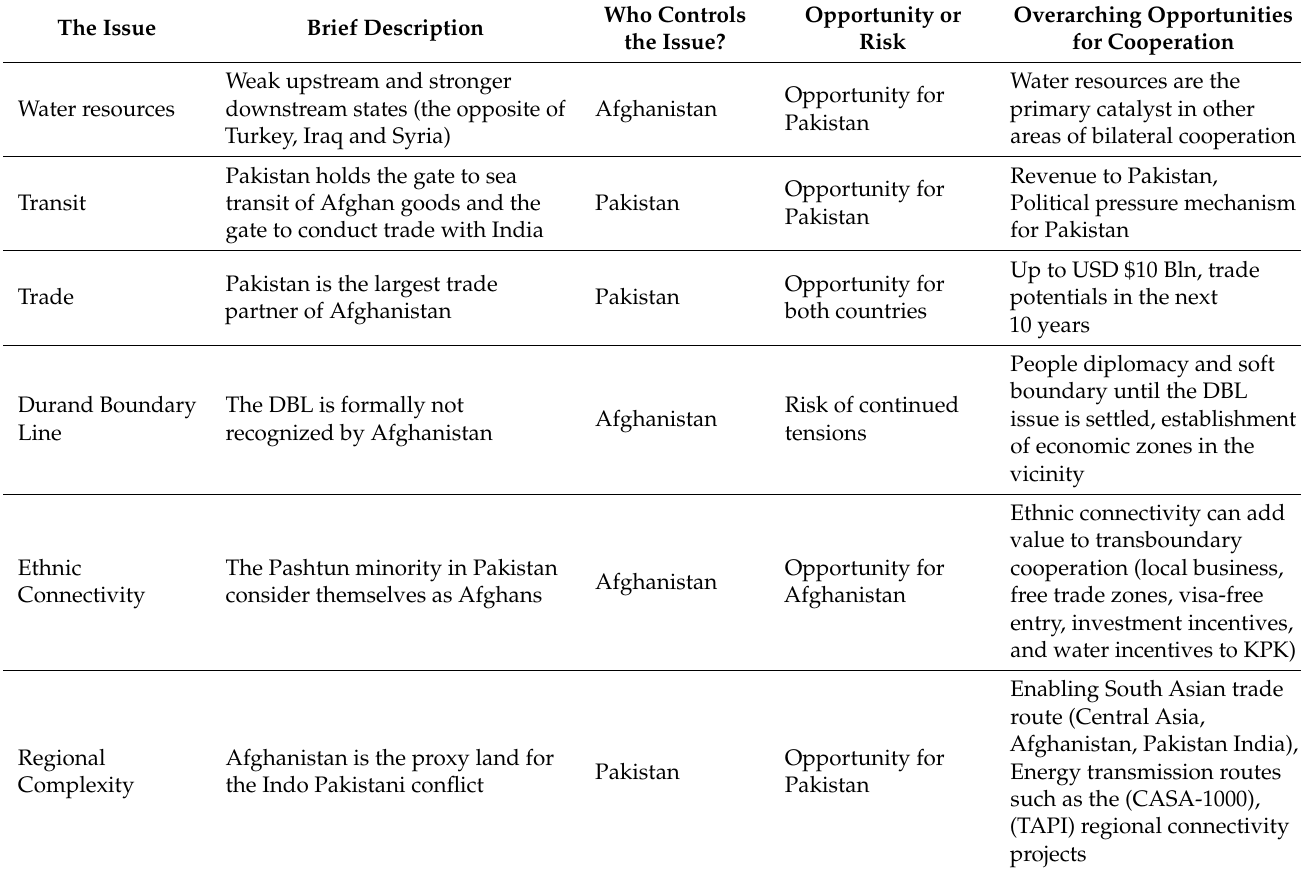
Table 5. KRB transboundary conflict and